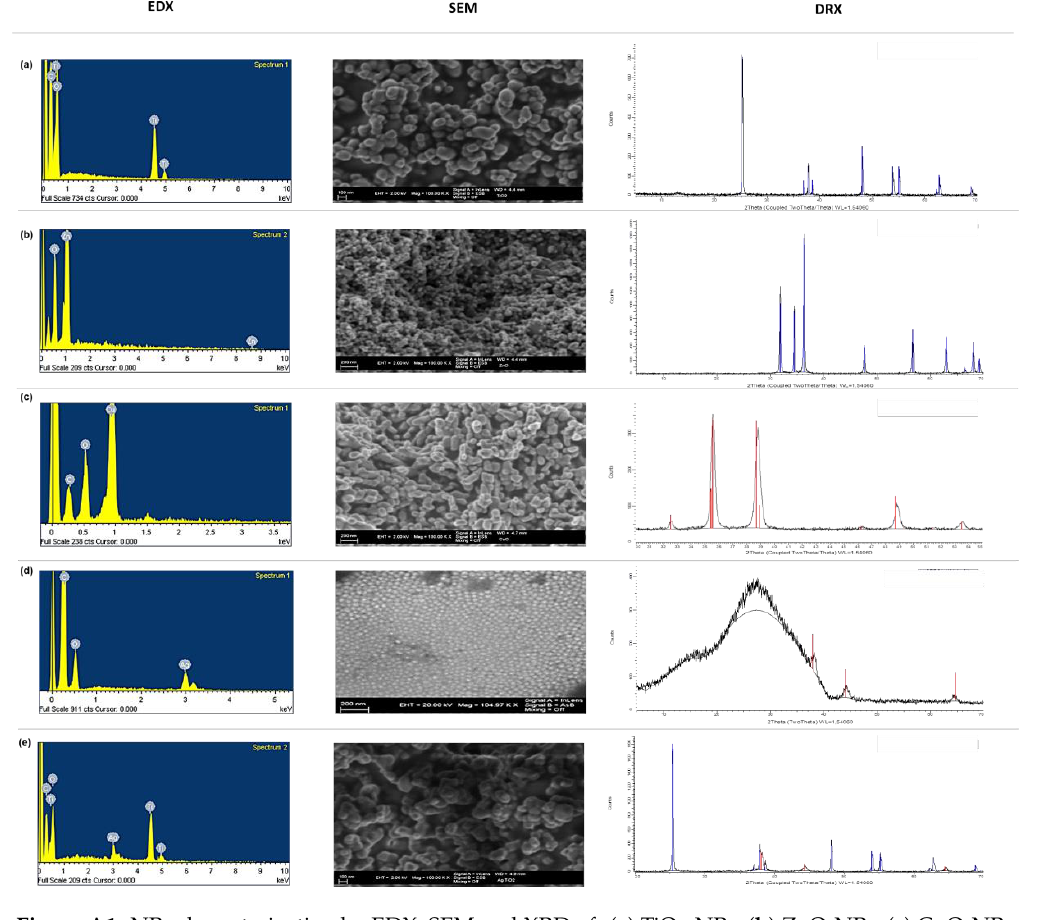
Figure A1. NPs characterization by EDX, SEM and XRD of: ( a ) TiO 2 -NPs, ( b ) ZnO-NPs, ( c ) CuO-NPs, ( d ) AgNPs and ( e ) Ag-TiO 2 -NPs.